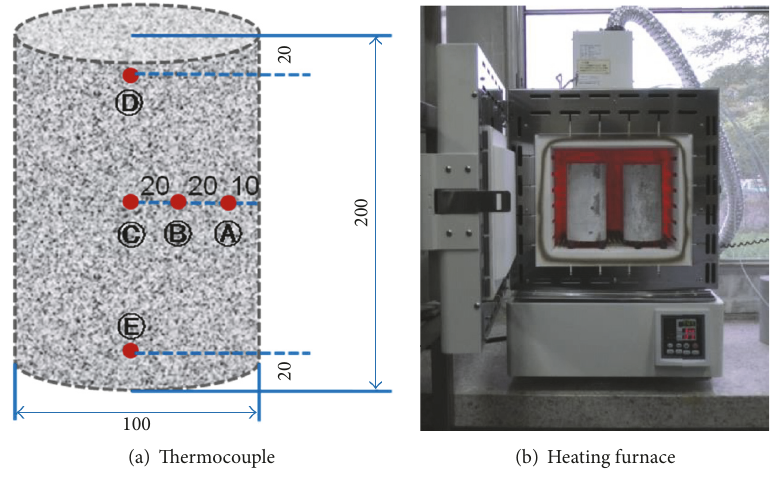
Figure 2: Setup for temperature measurement of PCM.